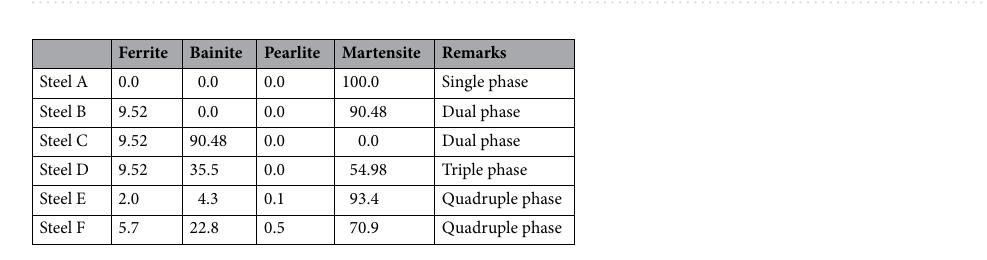
Figure 2. EBSD band contrast (BC) images of different steels. ( a – f ) corresponds to Steel A—F in the alphabetic order. Pixel size of images are 1592 by 1196.